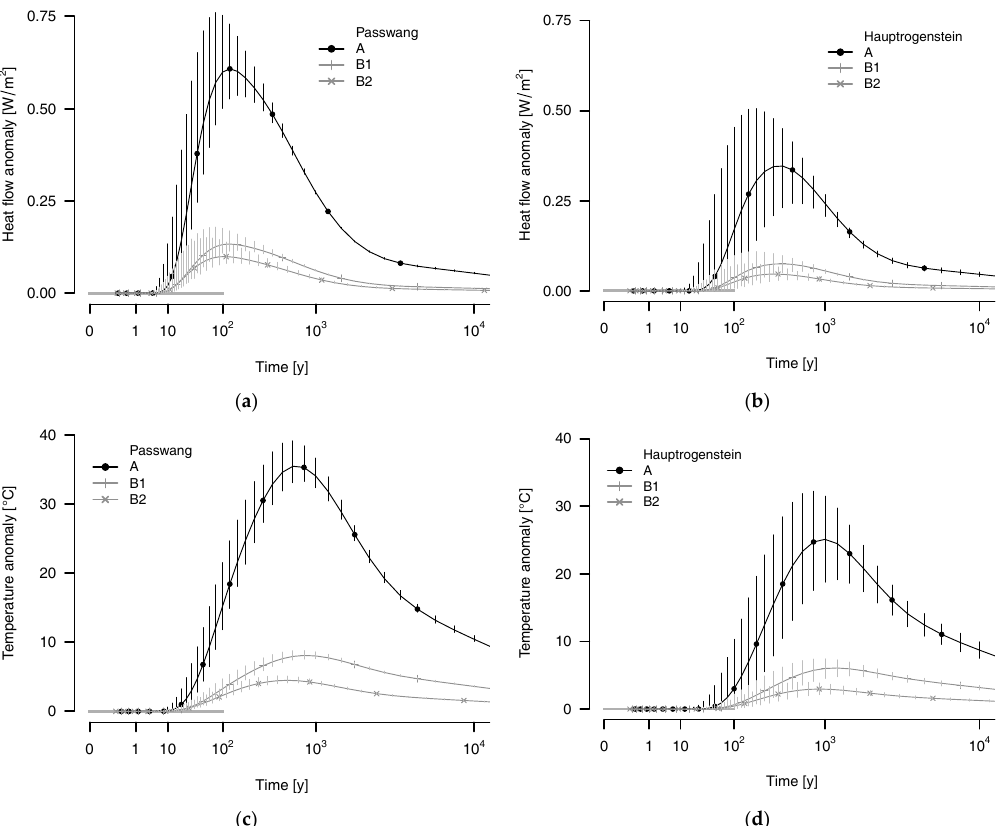
Figure 4. Comparison of thermal anomalies as expected at the reference levels for case A (black) and case B1 and B2 (grey) at the JO site (see section 1.3); ( a,b ) Heat flow anomaly; ( c,d ) Temperature anomaly in the absence of convective heat transfer.